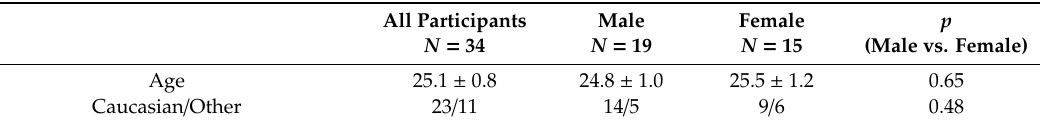
Table 2. Baseline clinical characteristics of participants.